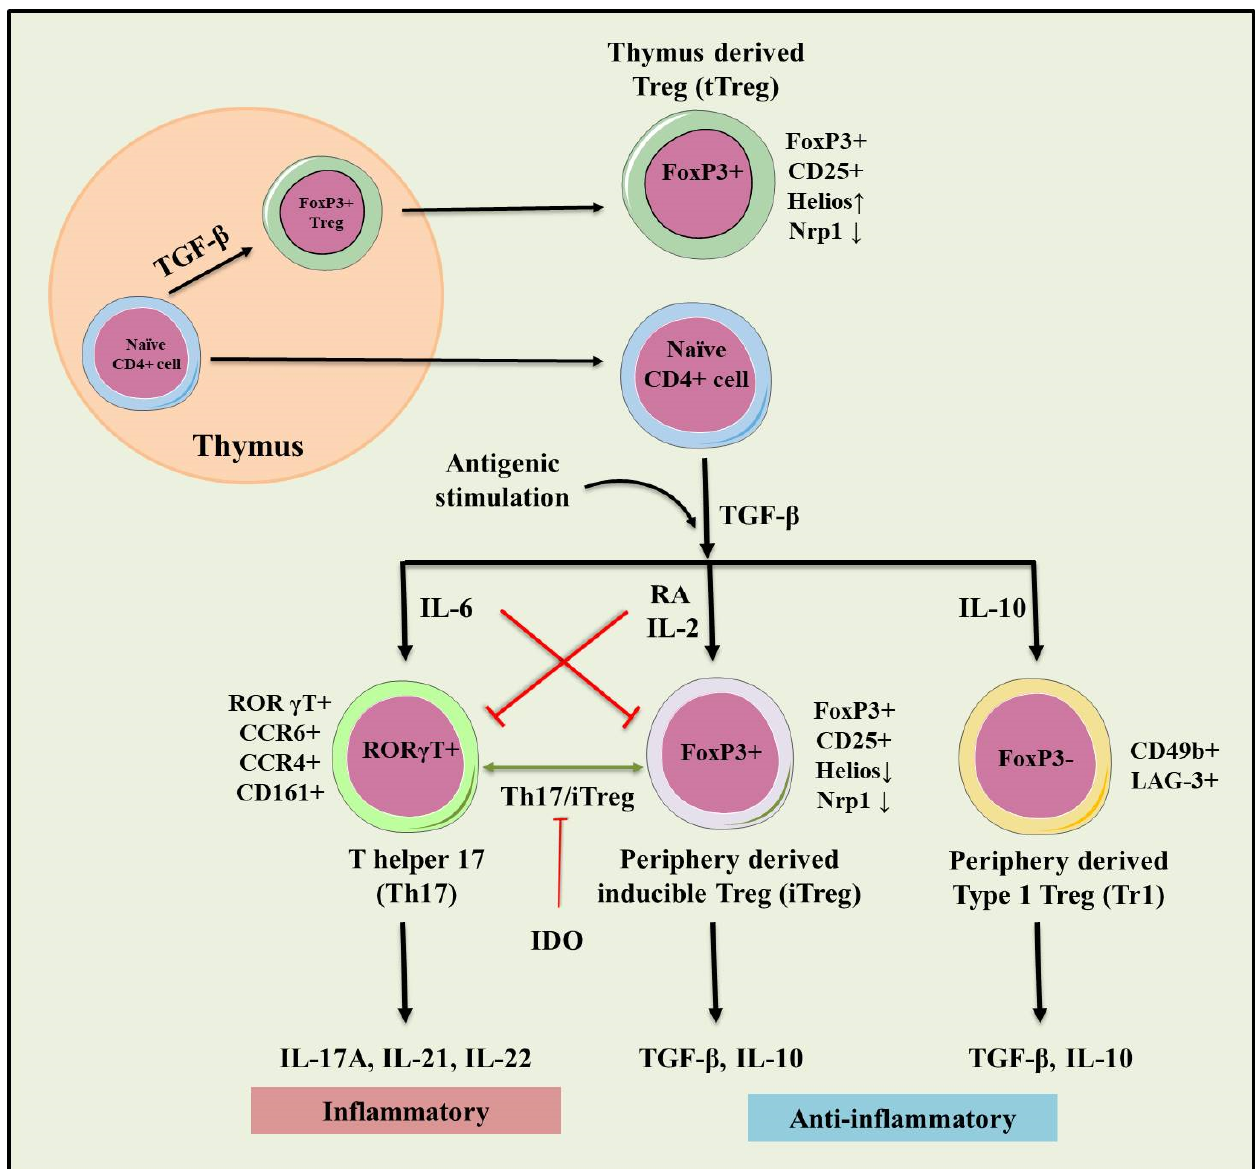
Figure 2. Role of natural and inducible regulatory T cells (iTregs) involved in the pathogenesis of IBD. Inflammation (IL-6) dependent interconversion of regulatory and effector T cell phenotype and role in dol 2, 3 dioxygenases (IDO) in the generation of inducible Tregs (iTregs) . Inflammatory (IL-17A, IL-21, IL-22) and immunosuppressive (TGF- β , IL-10) conditions following antigenic stimulation were seen during the conversion of Th17 to iTreg phenotype. This interconversion plays a crucial role in maintaining tolerance towards IBD.